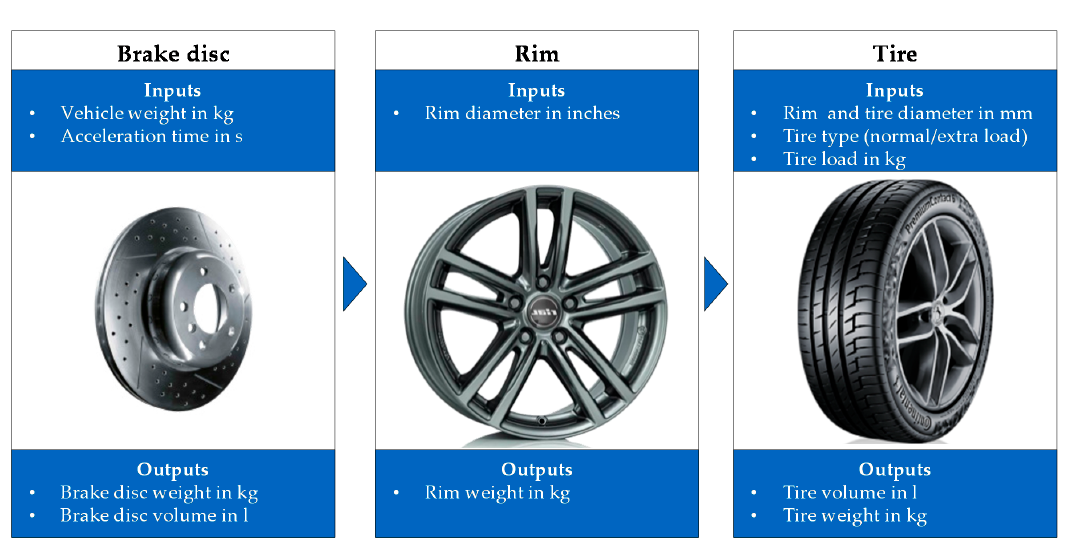
Figure 1. Overview of the subcomponent models, based on References [17,18].